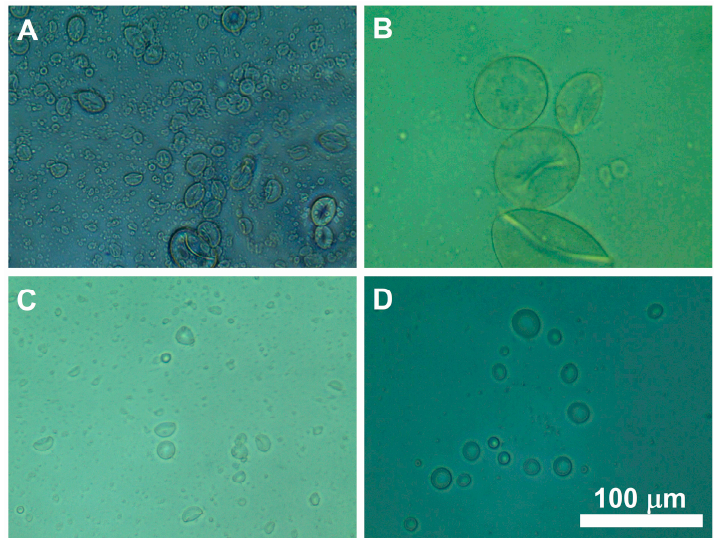
Figure 1. Representative images of microcapsules prepared during the optimization process. ( A ) Undesired shape and non-uniform size distribution; ( B ) Desired shape but large size; ( C ) Desired size but undesired shape; ( D ) Desired shape and size.